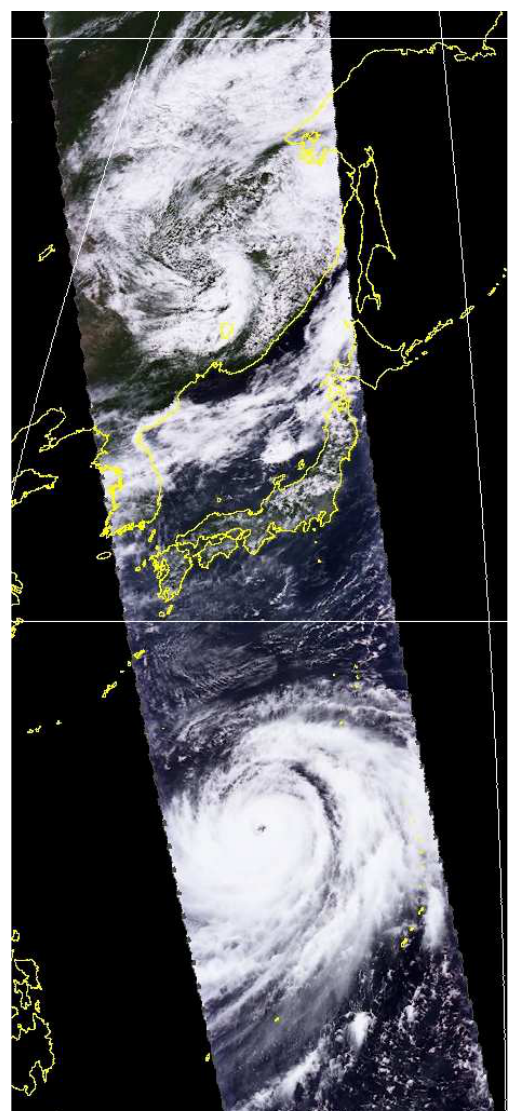
Fig. 1. POLDER true color composite of the common scene ob- served by MODIS and PARASOL on 2 September 2005 (MODIS swath is larger than POLDER but only the common part is presented here). The southern part of the image is typhoon Nabi as it moved North toward